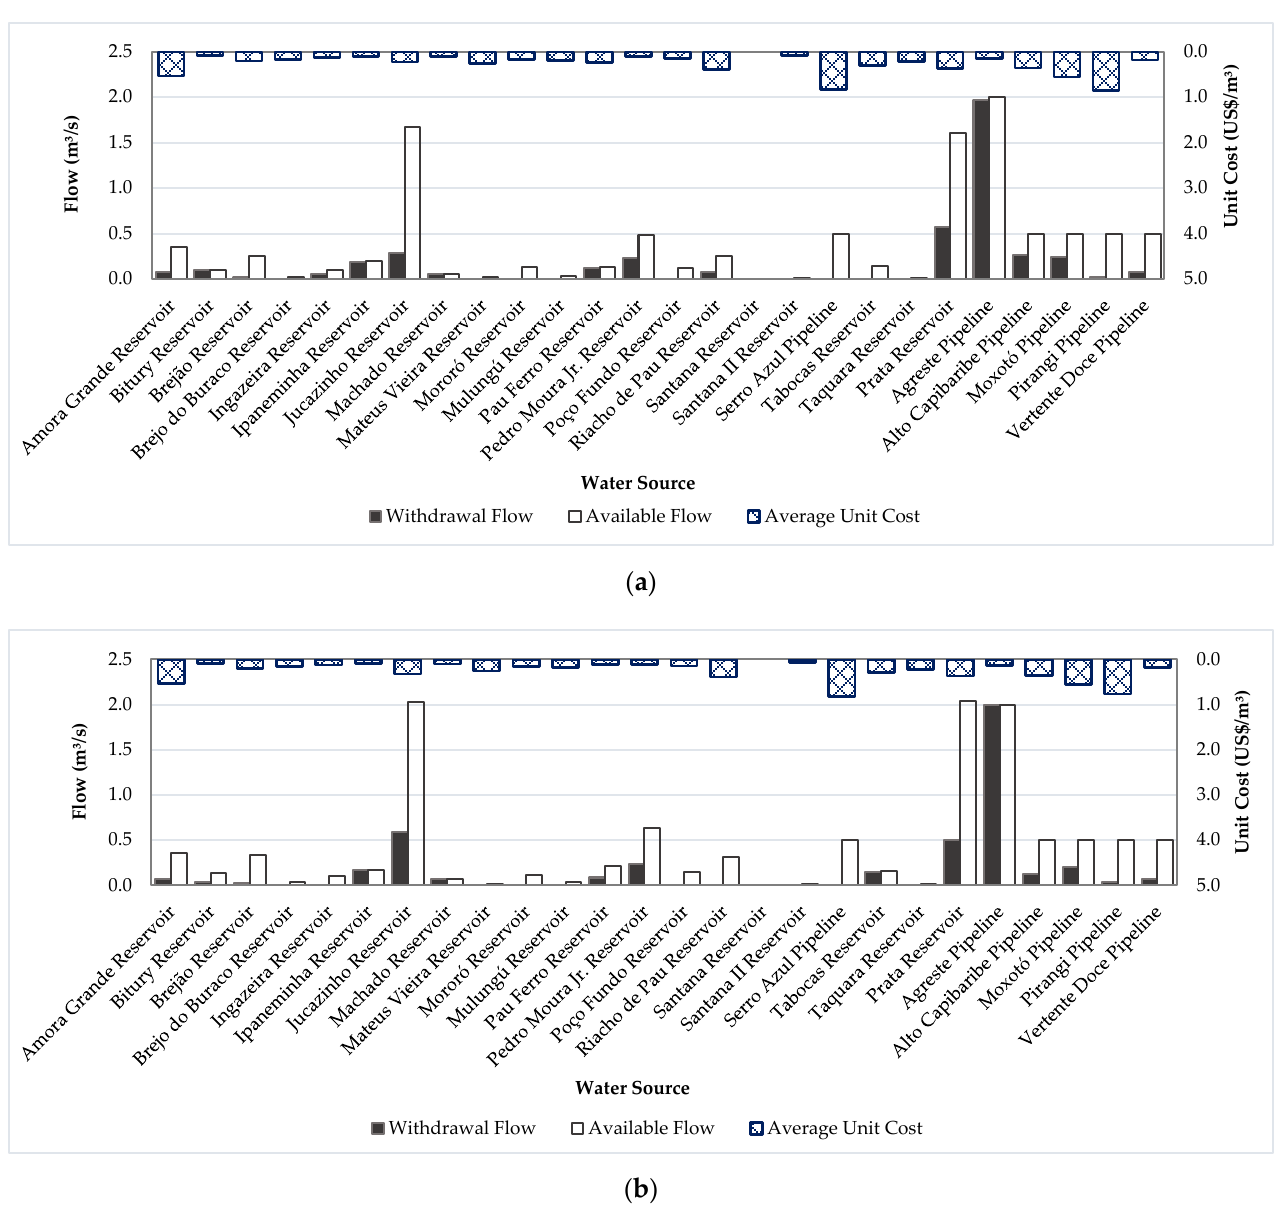
Figure 7. Comparison between available and captured flows given the unit costs of water sources in the months of ( a ) February and ( b ) July.